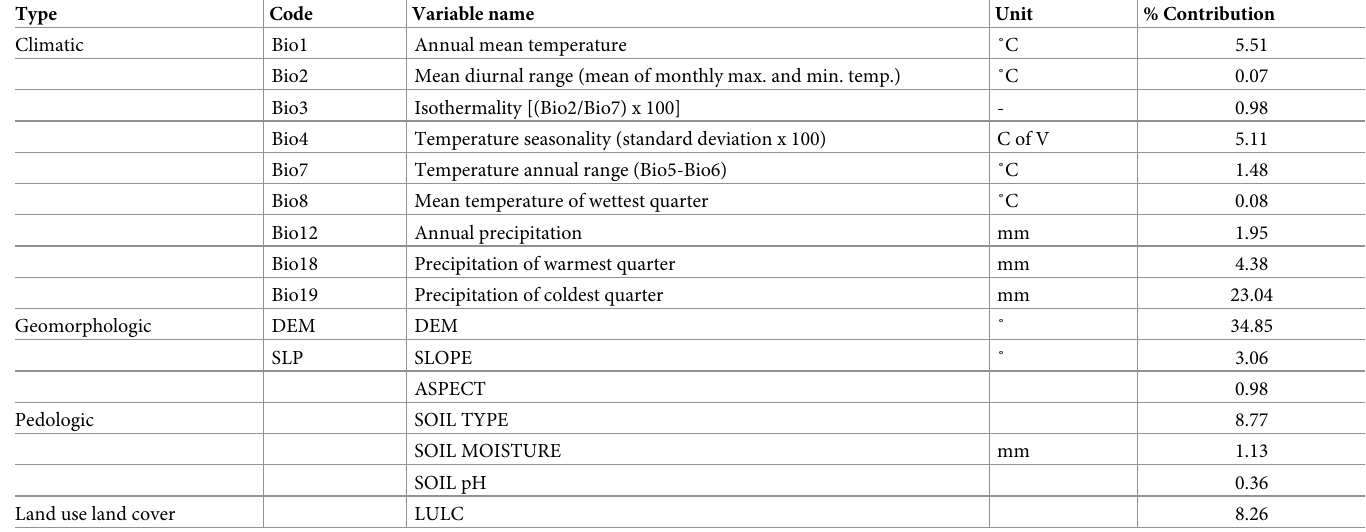
Table 1. Environmental variables and their percent contributions for predicting the potential distribution of D . hatagirea